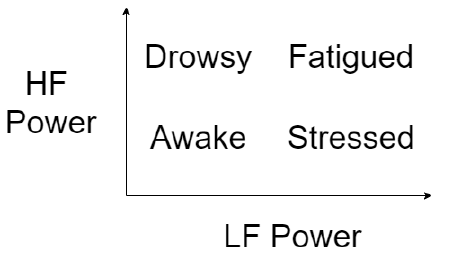
Figure 1. Hypothetical situation as a function of LF and HF power of HRV